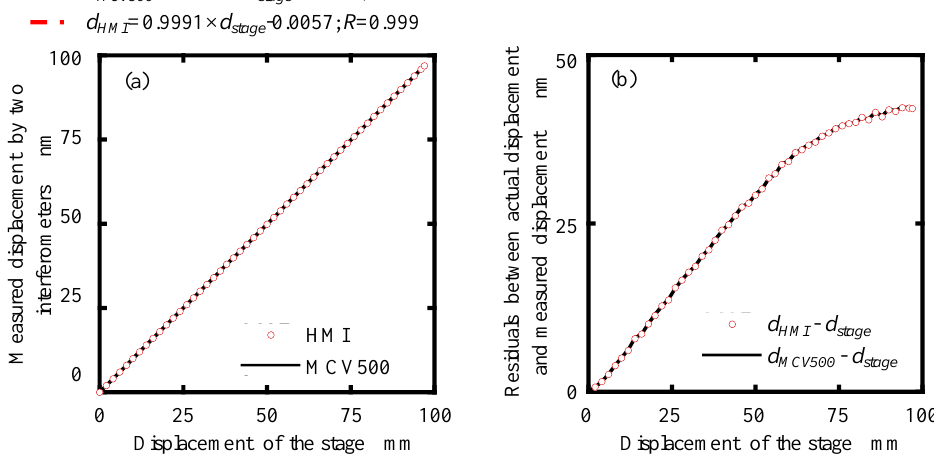
Figure 12. Experiment results for dynamic displacement measurement of a positioning stage: ( a ) measured displacement by the MCV500 and proposed MHI; ( b ) residual between the actual displacement of the stage and the measured displacement by two interferometers.